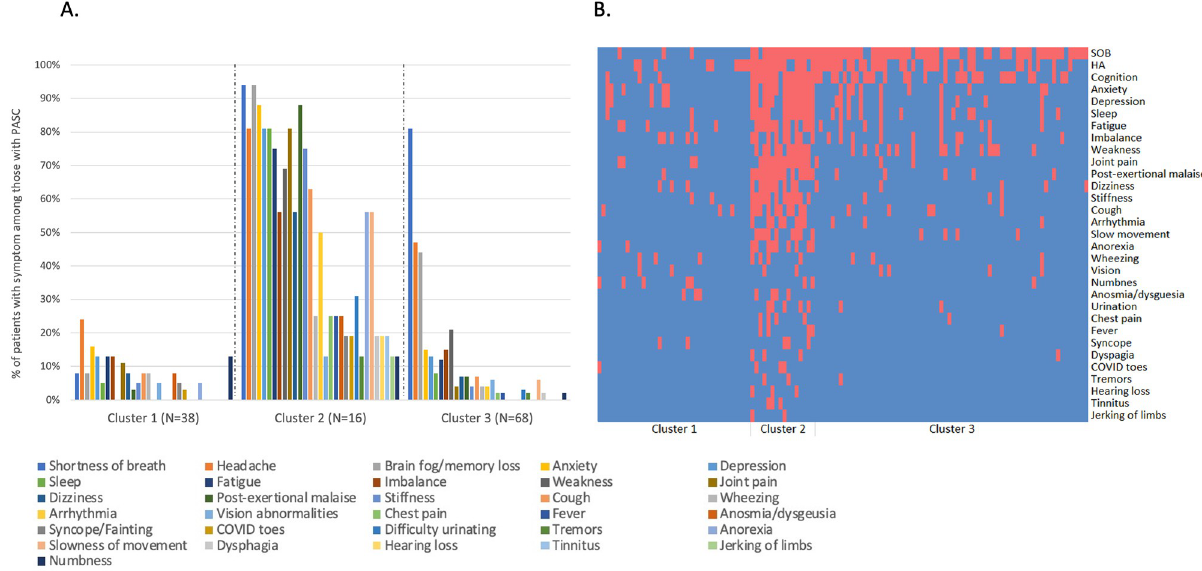
Fig 2. Symptom clusters among patients with PASC (N = 122). Cluster 1 has few symptoms; Cluster 2 has multiple symptoms with high rates of anxiety, depression and post-exertional malaise; Cluster 3 has high rates of shortness of breath, headache, and cognitive issues. Panel A. shows the frequency of each of the assessed symptoms in each cluster. Colors corresponding to each symptom are shown from left to right in the key. Panel B. shows a heat map for each patient, where red indicates presence of a symptom and blue indicates absence. SOB = shortness of breath; HA = headache.